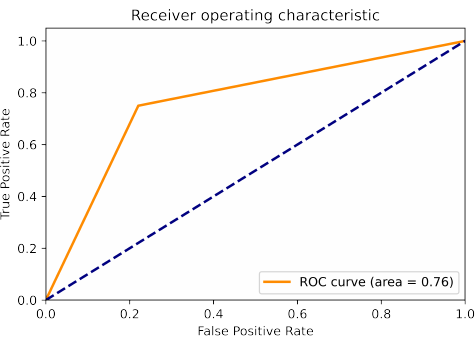
Figure 6. ROC curve obtained from the classification analysis based on